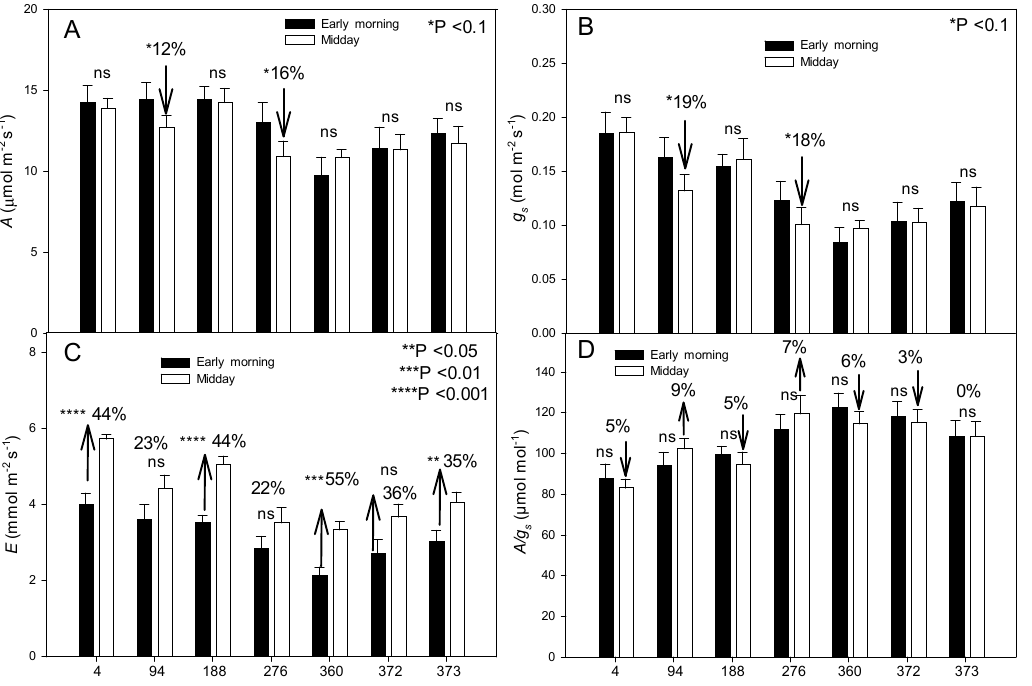
Figure 6. Differences between mean values of leaf gas exchange rates measured at early morning and midday for each clone during the post-veraison in 2020. Vertical bars represent the standard errors. ns, not significant; * p < 0.1, ** p < 0.05, *** p < 0.01, **** p < 0.001. Separation was made by Duncan’s multiple range test at the 95% confidence